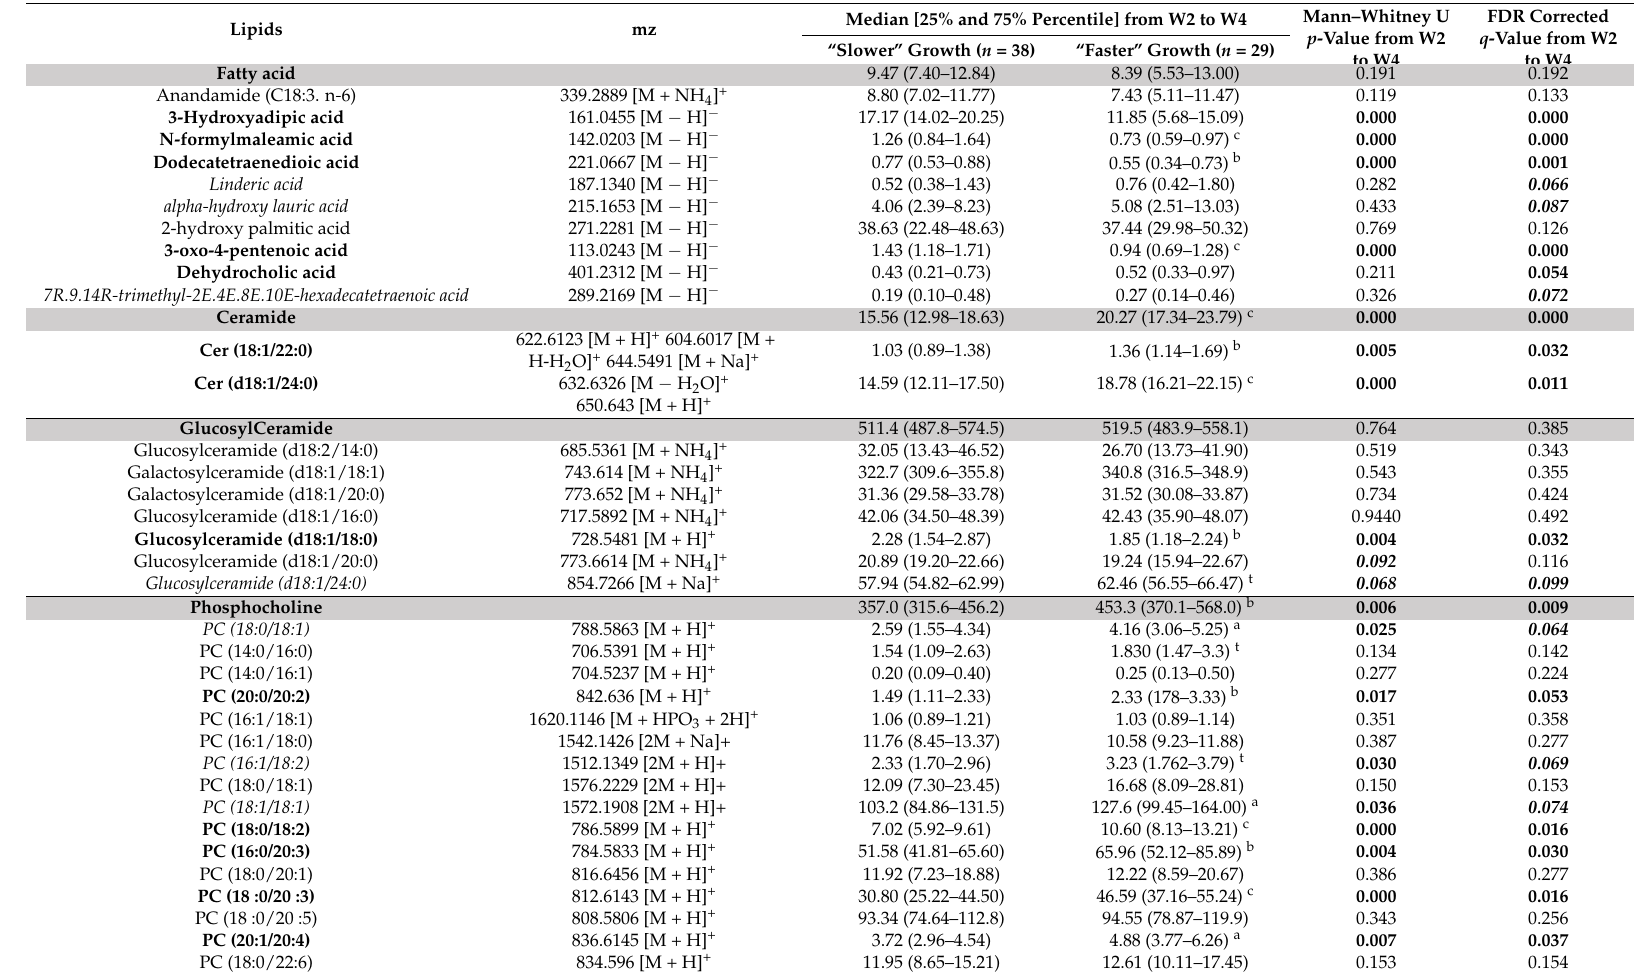
Table 3. Abundance (10 6 ) of annotated lipids that discriminated lipidotypes of breast milk provided to preterm infants with “faster” or “slower” growth during the W2–W4 lactation